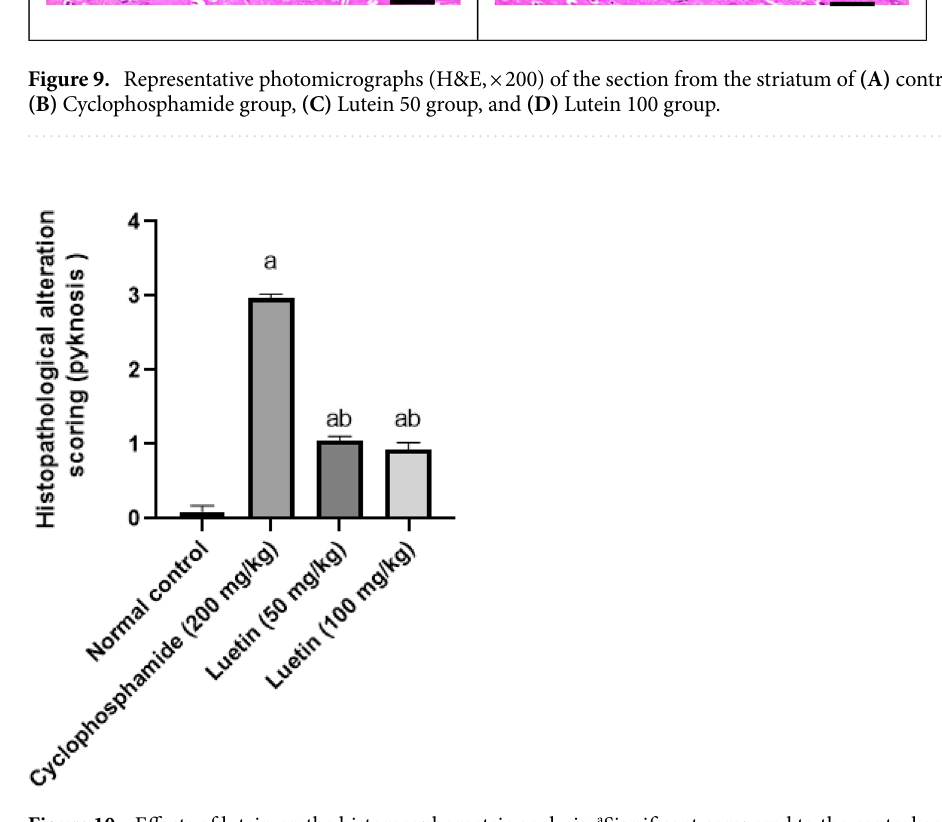
Figure 10. Effects of lutein on the histomorphometric analysis. a Significant compared to the control group. b Significant compared to the cyclophosphamide group at P <